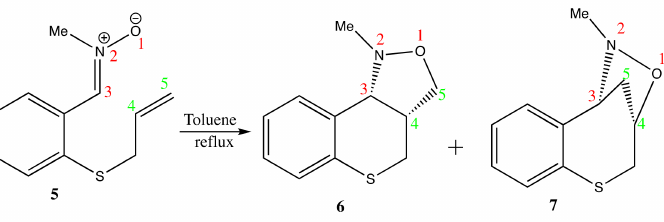
Scheme 5. Synthesis of tricyclic isoxazolidines from the nitrone-alkene 5 . Along the fused channel ( TS3-a ) yielding the cycloadduct 6 , BET reveals that five SSDs are required for the description of the C3-C4 and O1-C5 forming bond processes, Figures 6 and 7. Along the first SSD-I (with initial distances d (C3-C4) = 2.977 Å and d (O1-C5) = 3.057 Å) a slight diminution in the V(O1,N2) basin population coupled with